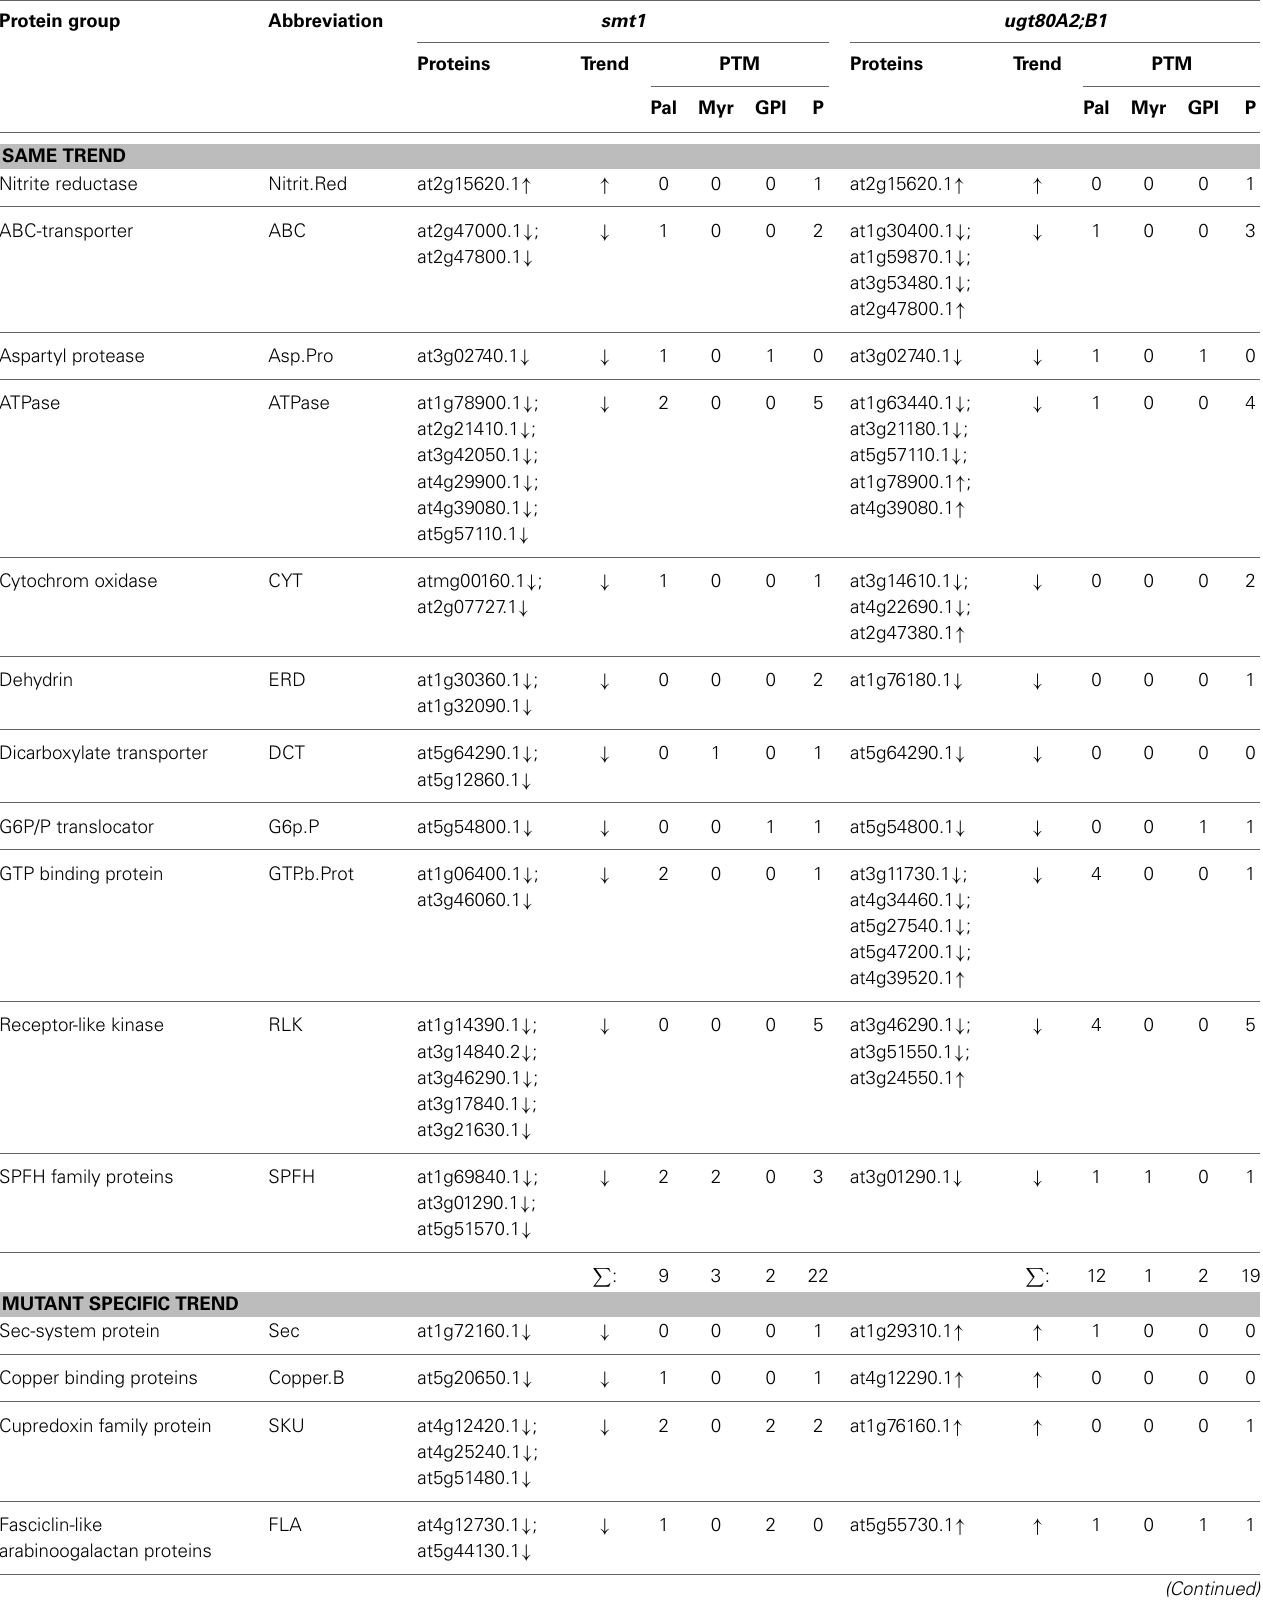
Table 1 | Selected protein groups showing significant alterations in DRM/DSF protein abundance ratios in smt1 and ugt80A2;B1 . Protein